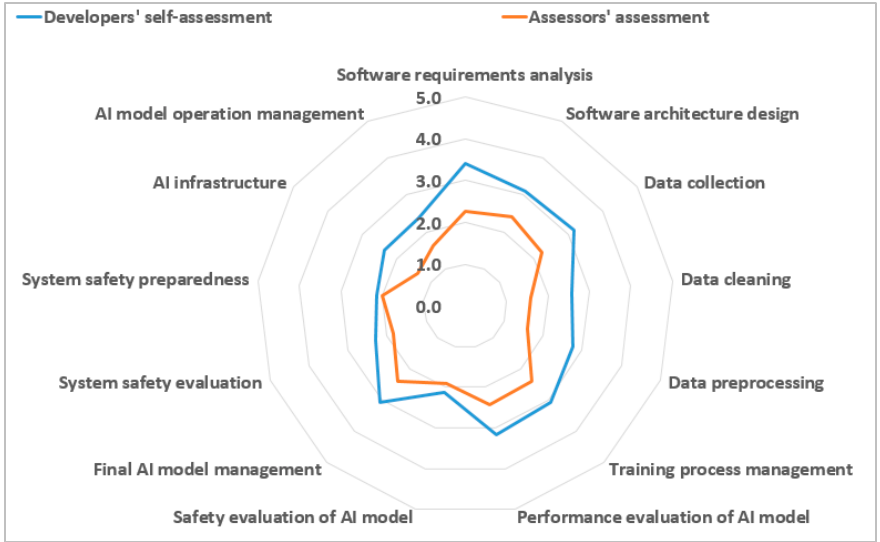
Figure 3. Developers’ self-assessments vs. assessors’ assessments.